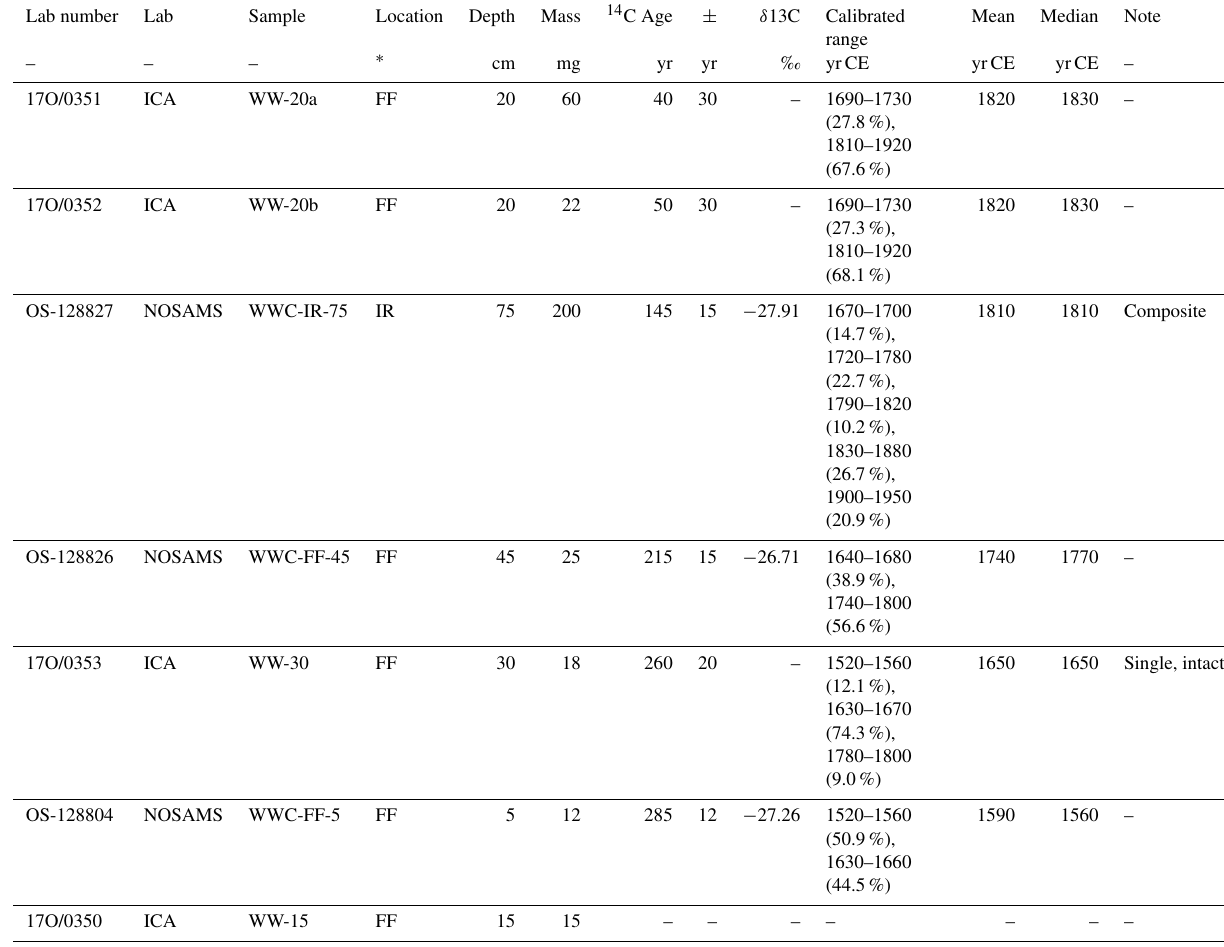
Table 1. Radiocarbon dating results from Winter Wonderland Cave. Lab